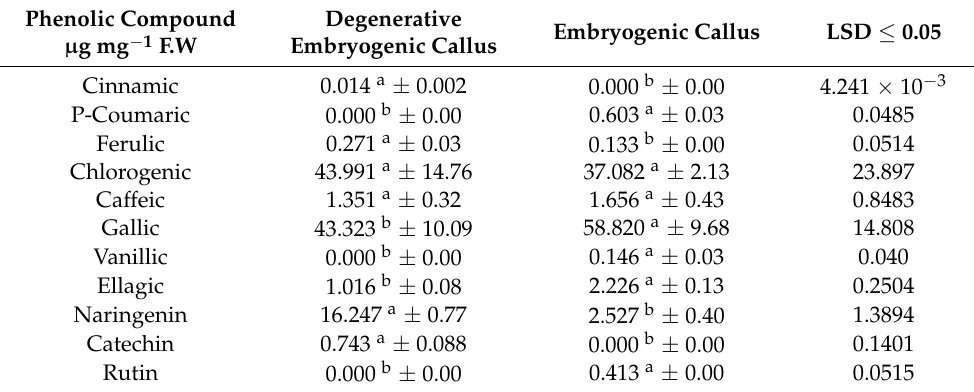
Table 1. Variations in the levels of different endogenous phenolic compounds in degenerative embryogenic callus (DEC) and embryogenic callus (EC) of Phoenix dactylifera cv. Barhee after 8 weeks on culture media containing ABA at 0.5 mg L − 1 and PEG at 5 g L − 1 . Phenolic Compound Degenerative µ g mg − 1 F.W Embryogenic